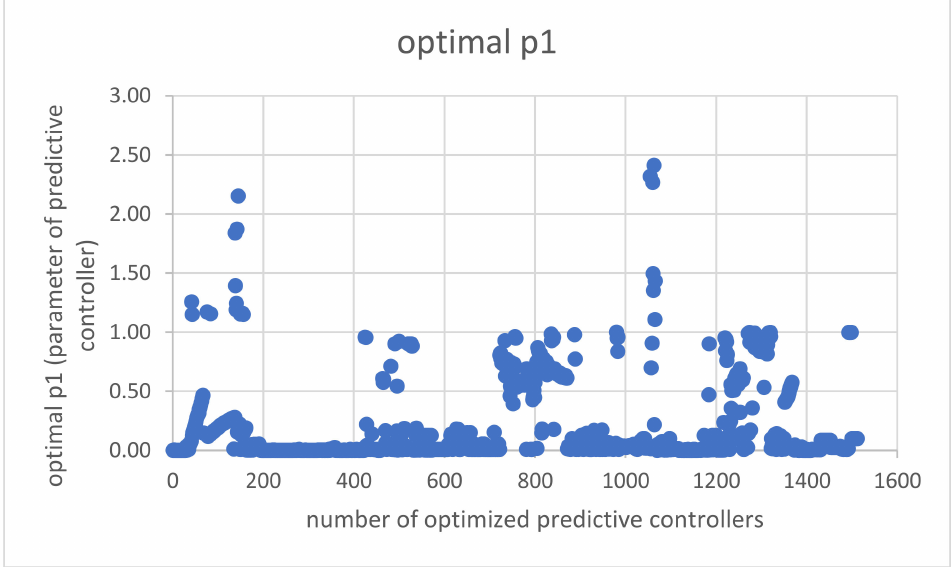
Figure 12. Optimal controller parameter p1of predictive controller (Supplementary Materials).